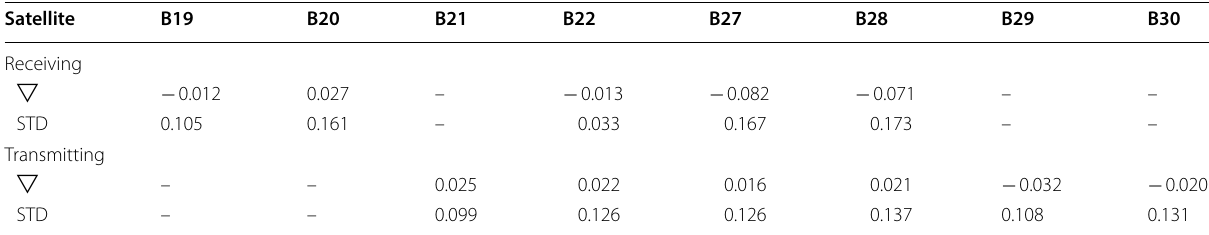
Table 5 Repeatability of the estimated Ka‑biases for each satellite obtained by EXP5 and the differences (denoted by ▽ ) between the mean estimated Ka‑biases obtained by EXP5 and those obtained by EXP2 Satellite Receiving ▽ − 0.012 STD Transmitting